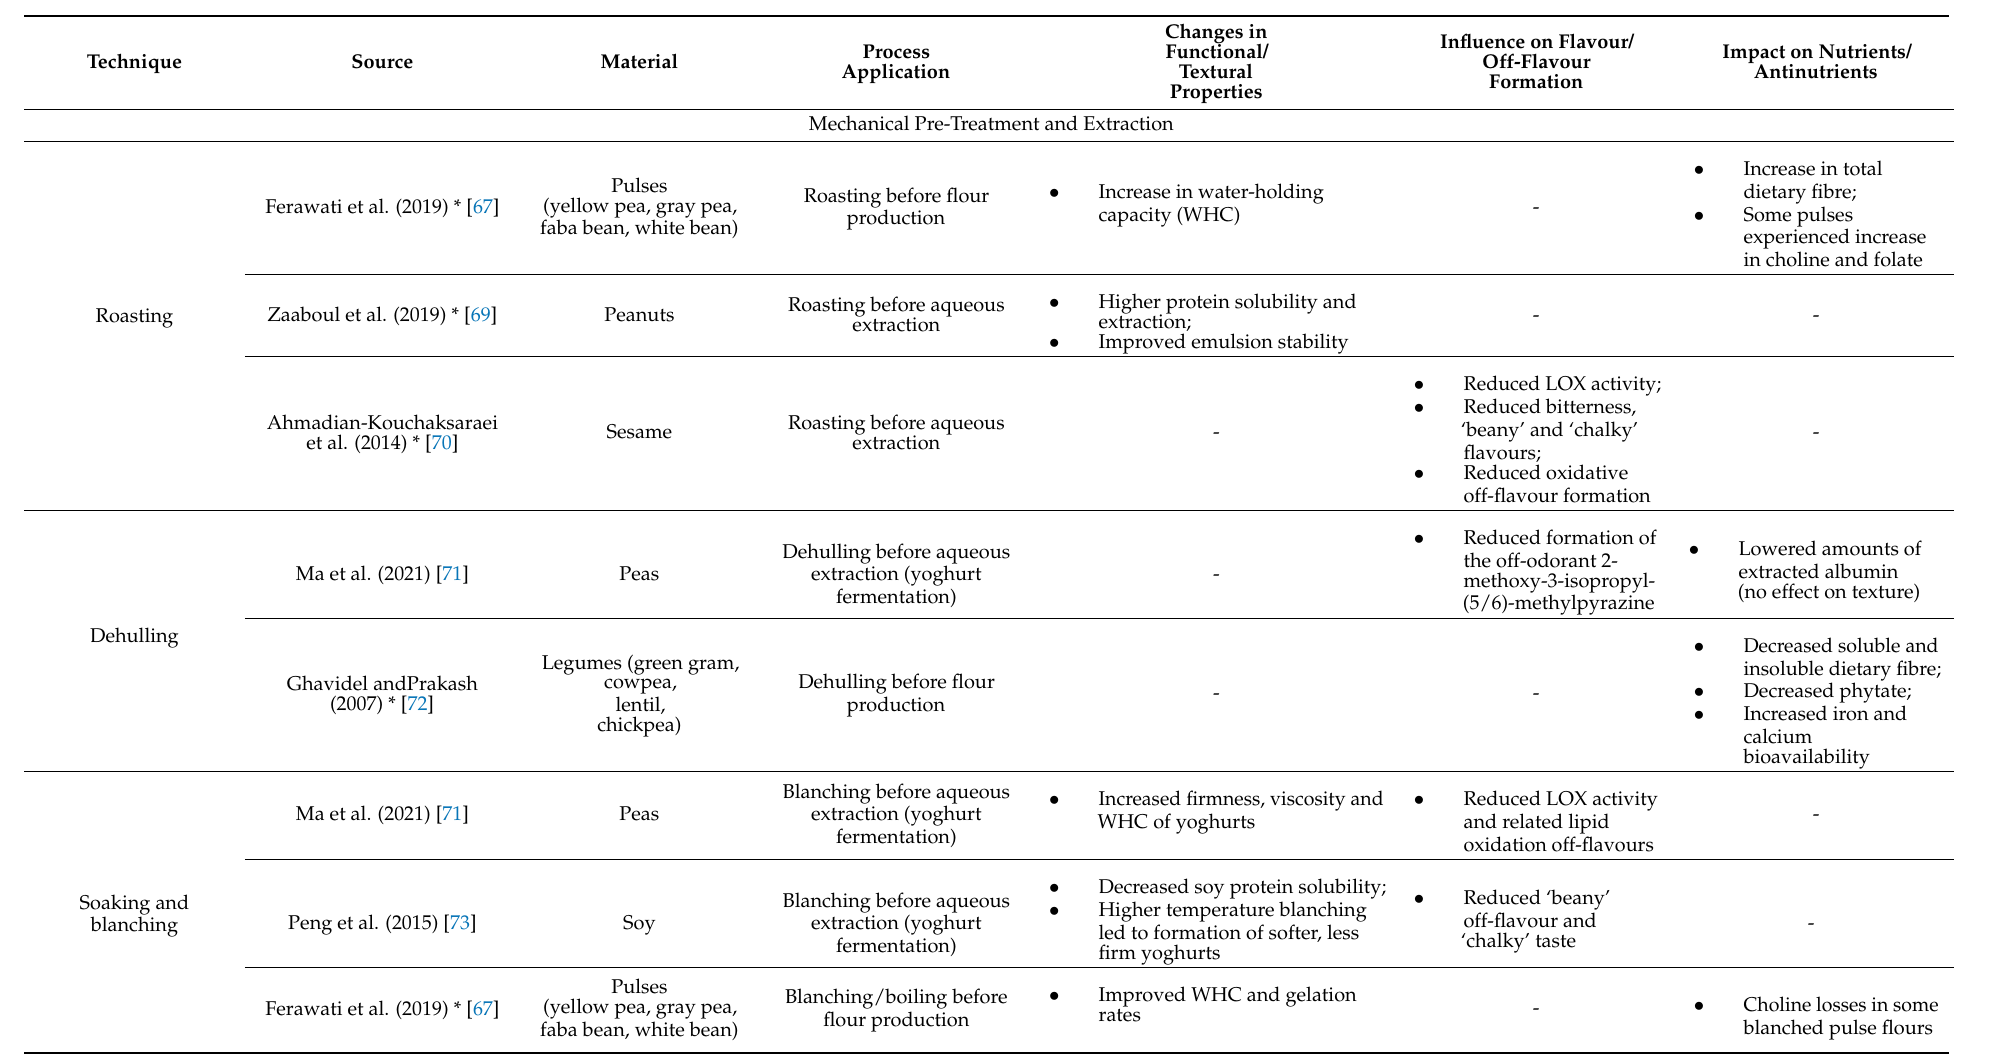
Table 2. Applications of various processing techniques for the extraction of plant-based ingredients intended for dairy analogue